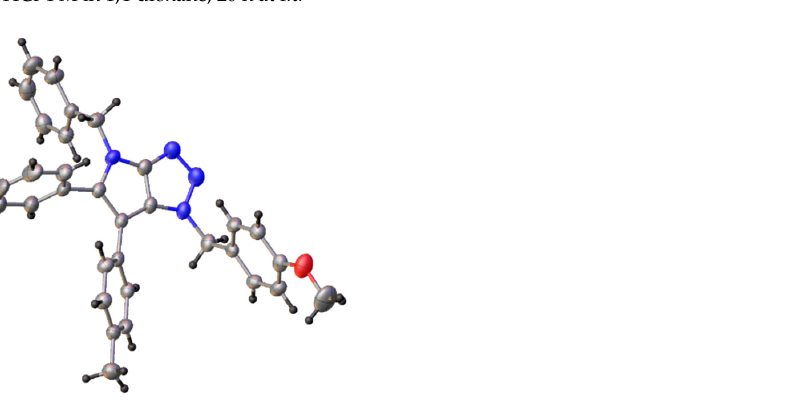
Figure 3. Hirshfeld surface analysis [36] of 41 , showing ( a ) the principal intermolecular contacts (red zone on the surface) with some main interacting molecules and fingerprints [37] of ( b ) H–H contacts, ( c ) C–H contacts ( d ) O–H contacts and ( e ) N–H contacts. 3. Conclusions In summary, the quick access to original N–1, N–4 disubstituted pyrrolo[2,3- d ][1,2,3]triazoles has been described herein using a one-pot MCR leading to a single regi- oisomer of the attempted heteroaromatic skeleton in good yields. The functionalization of C –5 and C-6 positions was also investigated. First, a regioselective halogenation was per- formed in the C-6 position followed by Suzuki–Miyaura coupling reaction to introduce (Het)aryl moiety with success. Next, the same sequence was also realized with the last free C–5 functionalizable position, with the same efficiency. The scope of the Suzuki– Miyaura reactions for each position was studied and showed an excellent compatibility with a wide range of boronic acids. This work allows access to a novel class of tetra sub- stituted pyrrolo[2,3- d ][1,2,3]triazoles which will undoubtedly have a major impact on the further synthesis of new bioactive compounds that contain the rare pyrrolo[2,3- d ][1,2,3]triazole scaffold as the central skeleton. Efforts to achieve these objectives, and particularly to study the reactivity of the triazolic nitrogen atoms involved in the bicyclic system, are currently in progress. 4. Materials and Methods 4.1. General Information 1 H NMR and 13 C NMR spectra were recorded on a Bruker DPX 400 Mhz instrument using CDCl 3 and DMSO– d 6 . The chemical shifts are reported in parts per million ( δ scale),